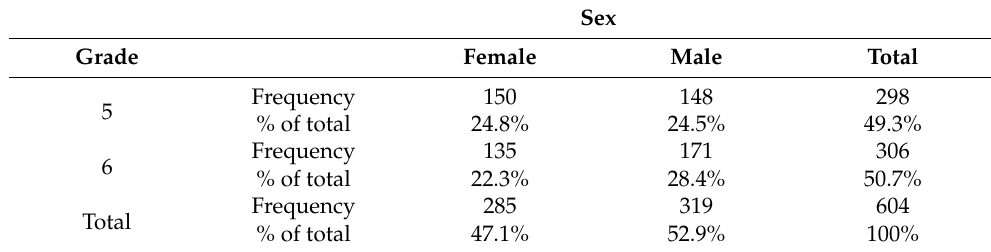
Table 1. Number of participants by sex and school